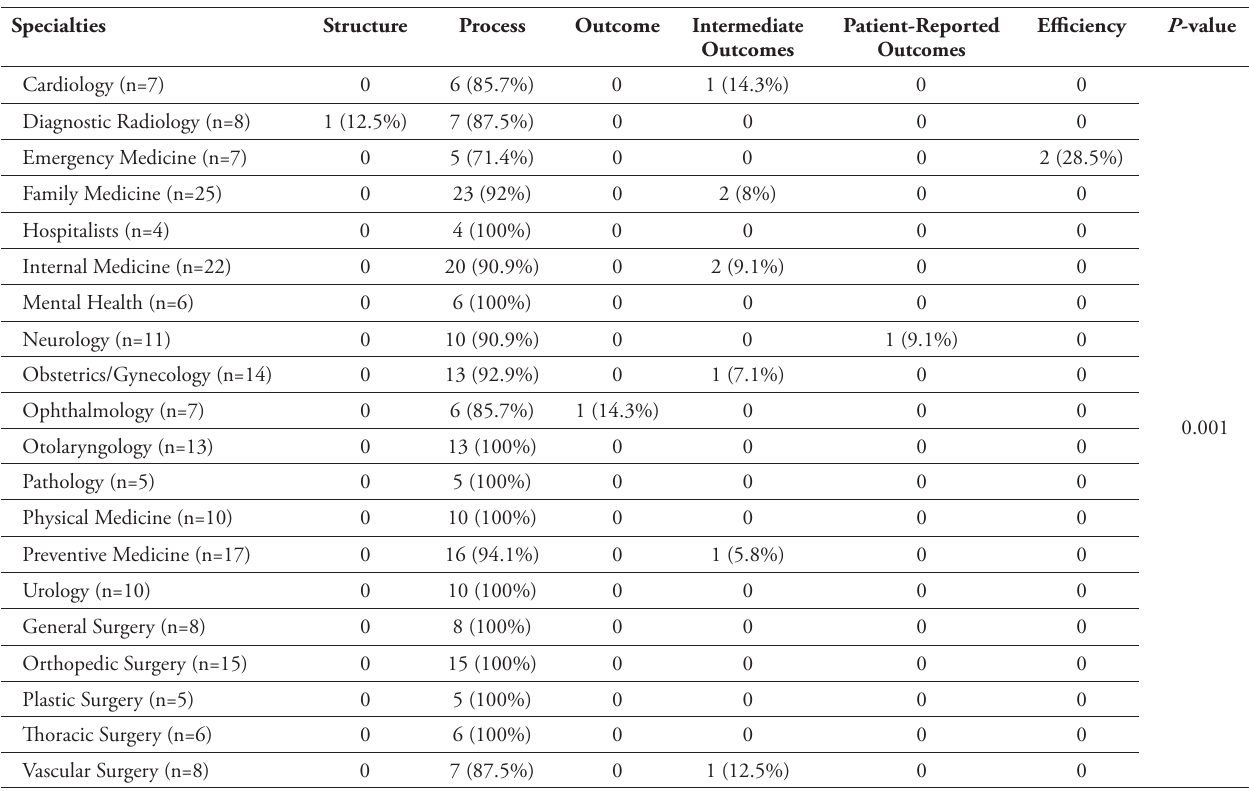
Table 5A. MIPS Characteristics by Specialty Type, 2019, Measure Types Measure Characteristics